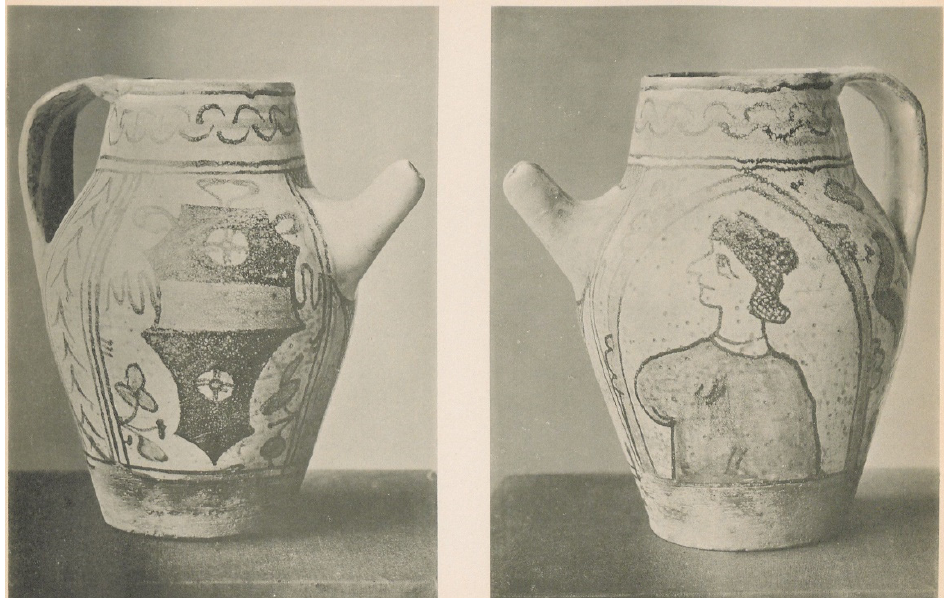
Figure 1. Photograph provided by Wilhelm von Bode for the photo volumes ( Abbildungen aus dem Archiv des Verbandes von Museumsbeamten. Dritte Folge 1910), an apothecary jug in the style of the 14th–15th century. Scan by Kunstbibliothek Berlin, used by permission.